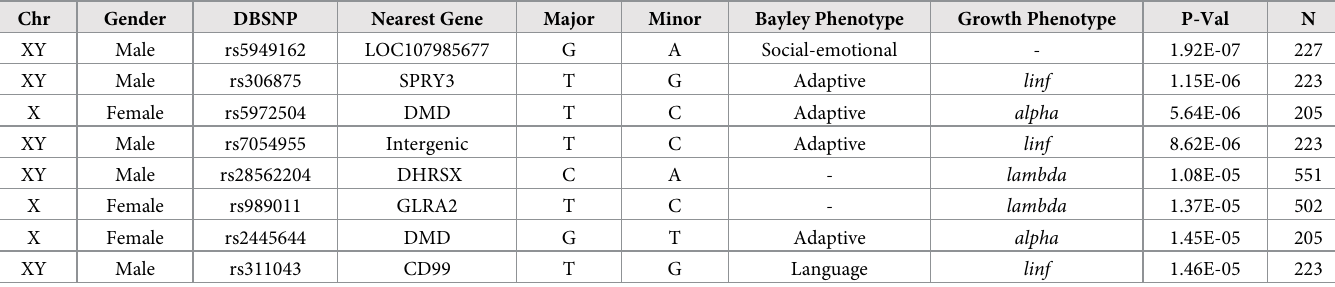
Table 5. Loci on X and/or Y chromosomes with p-values < 1.5x10 -5 .